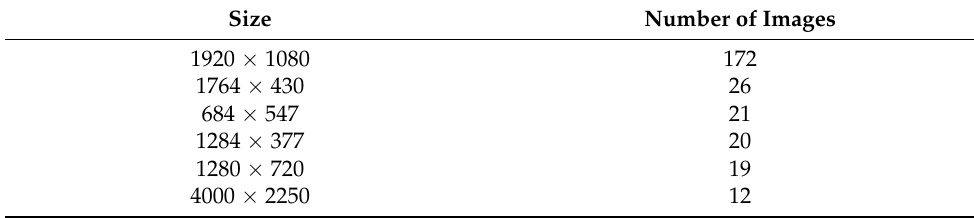
Table 6. Image size in the PSU (Prince Sultan University)